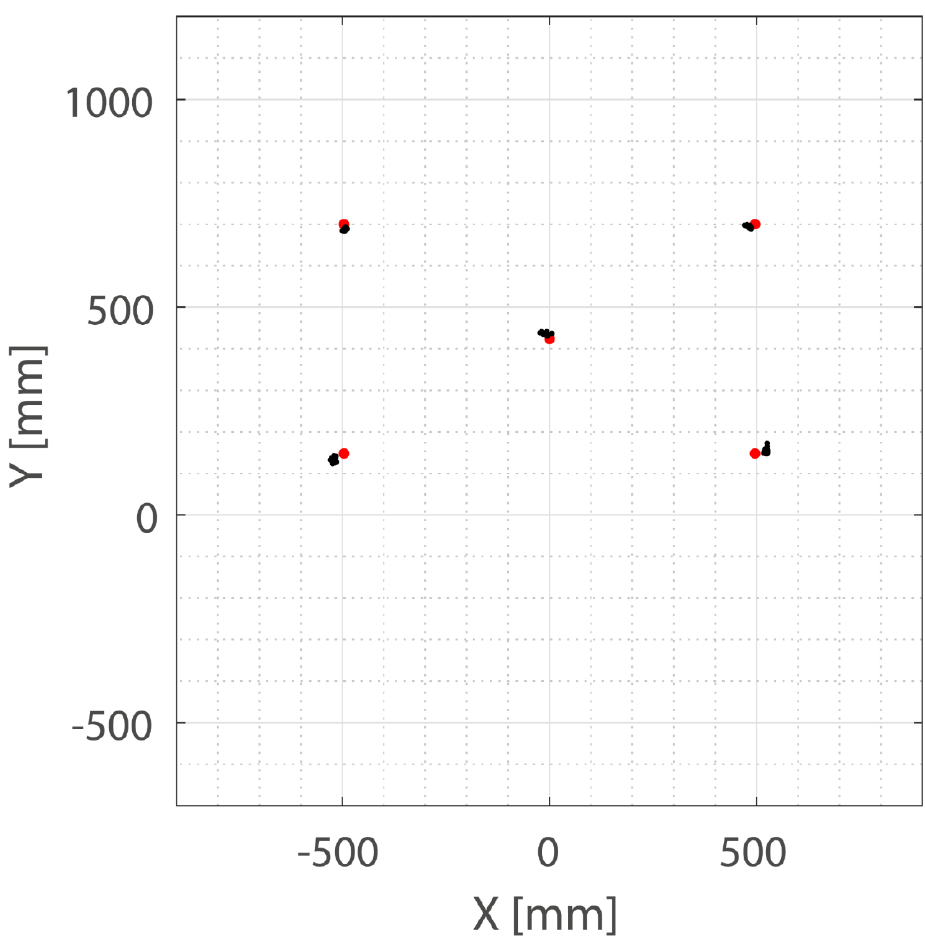
Figure 13. Positions that have been reached by NURSE device during repeatability test (black points) versus the programed critical positions (red points).